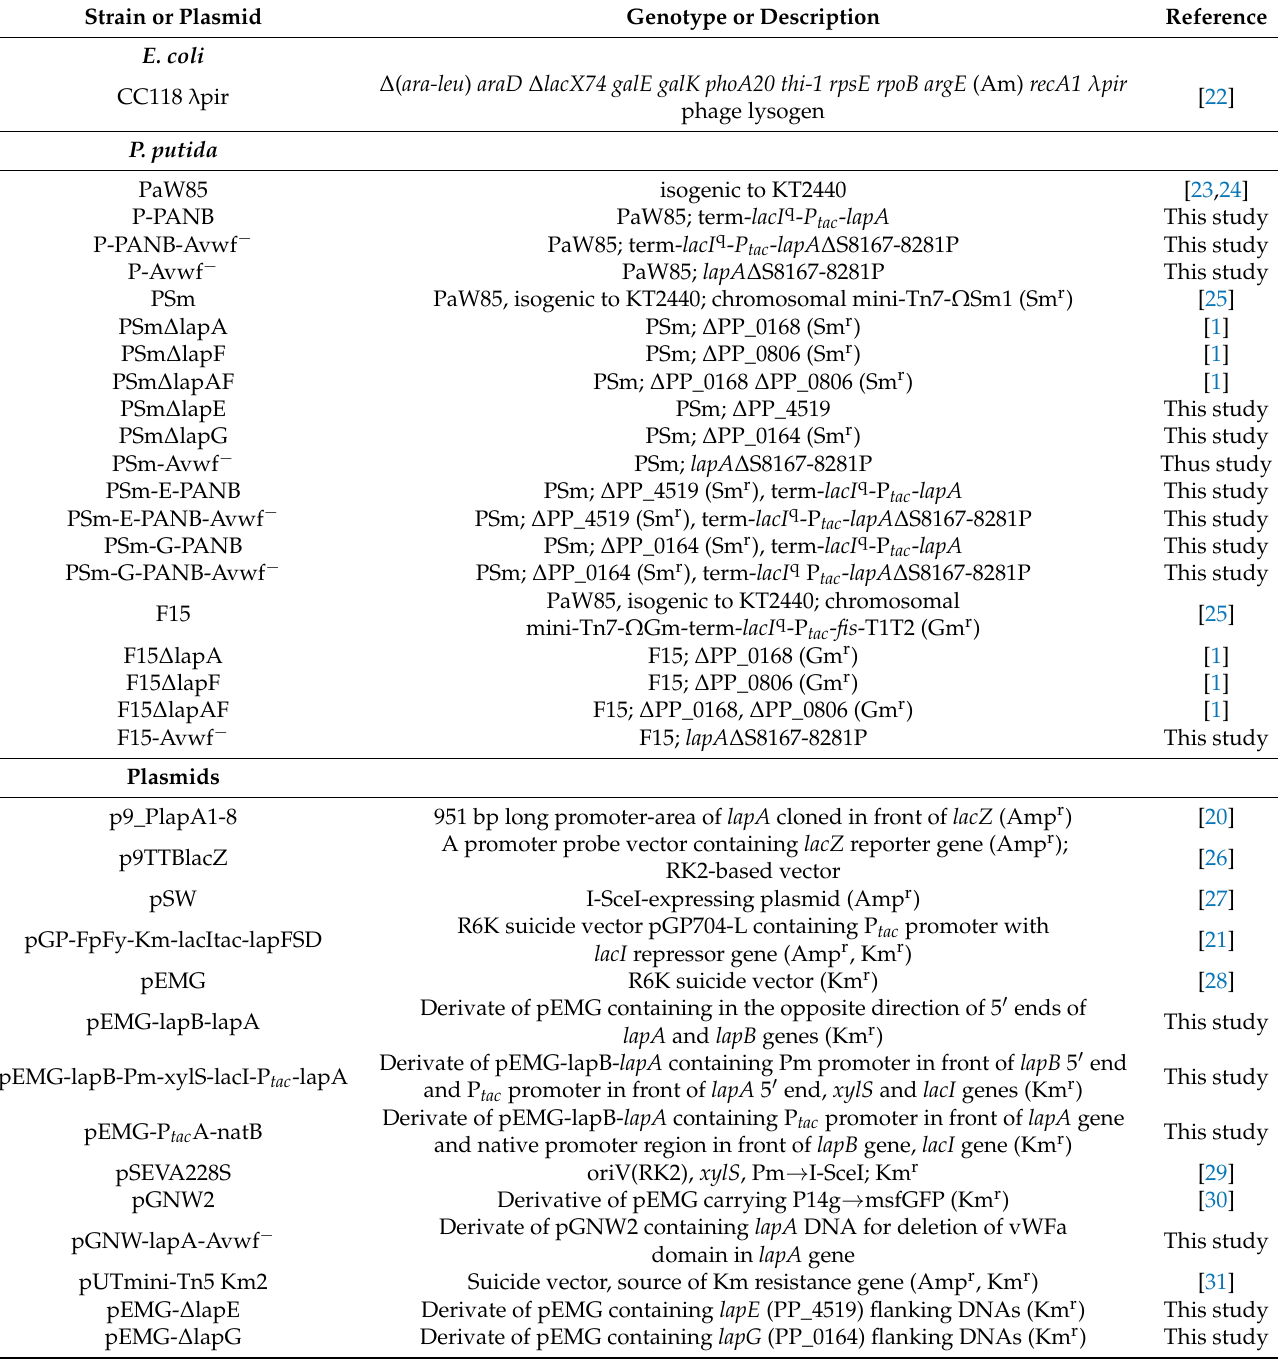
Table 1. Bacterial strains and plasmids used in this